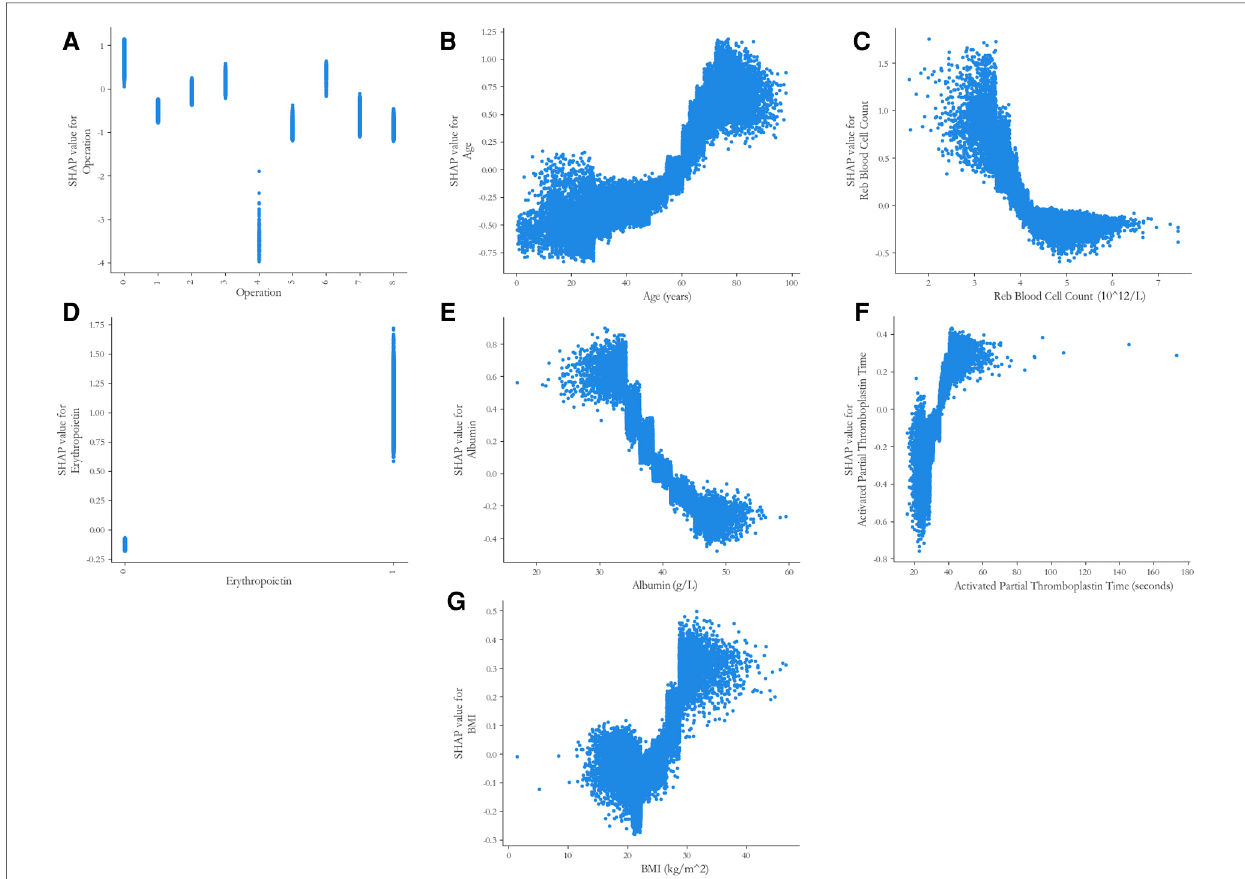
FIGURE 4 SHAP partial dependence plots of the fi ve predictors in the catBoost model. Each plot shows how a single risk factor affects the outcome of the prediction model. SHAP values for speci fi c factors exceed zero, representing an increased risk of postoperative RBC transfusion in orthopedic surgery patients. SHAP, SHapley Additive exPlanations. ( A ) Code on the x-axis: 0=Repair and plastic operations on joint structures; 1=Incision and excision of joint structures; 2=Operations and procedures on other systems; 3=Incision, excision, and division of other bones; 4=Operations on muscle, tendon, and fascia of hand; 5=Operations on muscle, tendon, fascia, and Bursa, except hand; 6=Other procedures on musculoskeletal system; 7=Reduction of fracture and dislocation 8=Other operations on bones, except facial bones; ( D ) Code on the x-axis: 0=no use, 1=use.